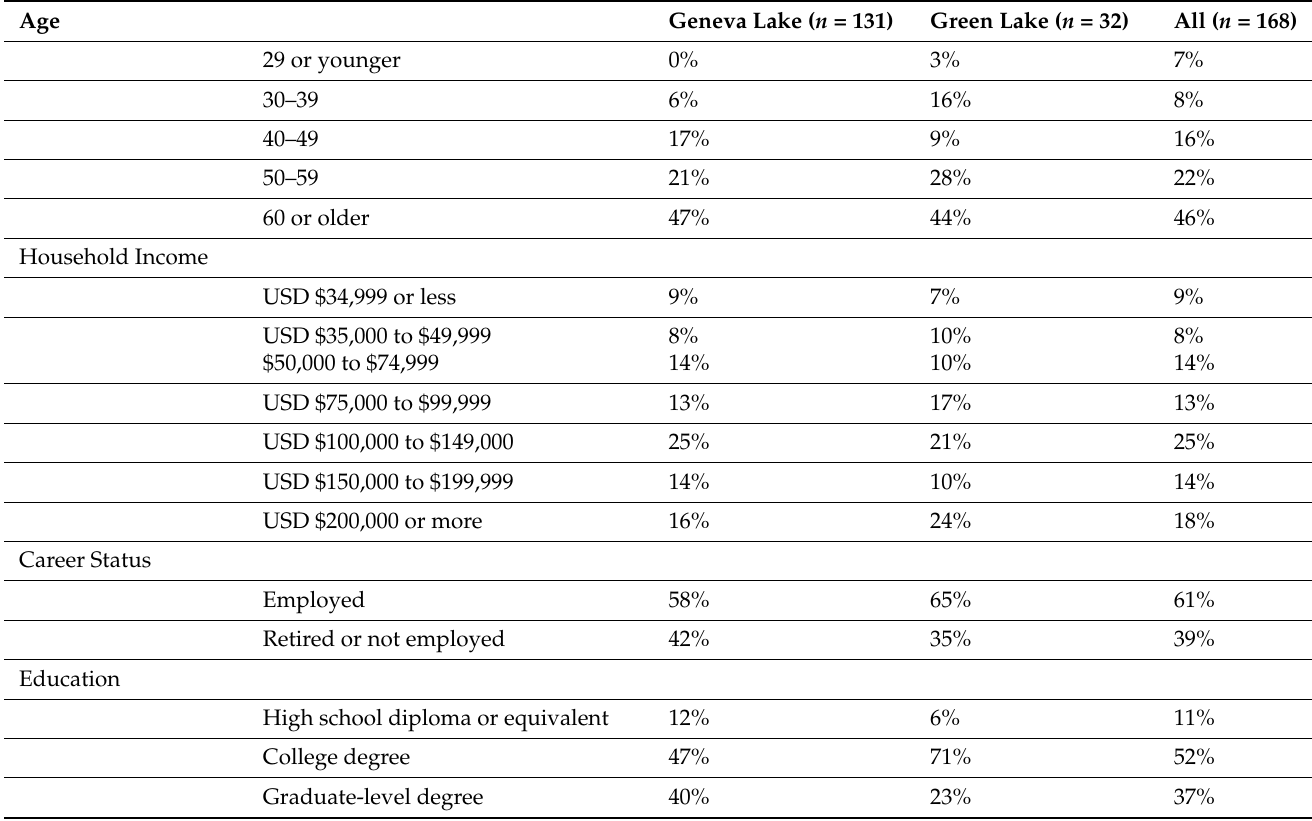
Table 3. Citizen survey respondent